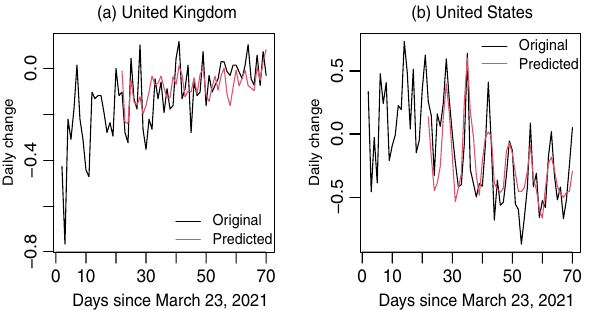
Figure 3. Original and predicted changes in ICU admission ( △ ICU ) since March 23, 2021 in ( a ) United Kingdom and ( b ) United States.